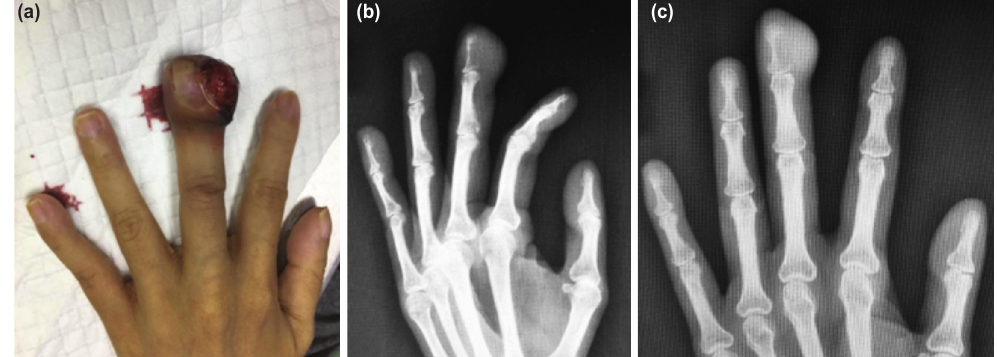
(a) Clinical picture of the left middle finger at three and a half months after onset of symptoms showing fungating mass at the Fig. 2: radio-dorsal aspect of the middle finger extending to the distal crease, (b and c) AP and oblique radiograph of the left middle finger showing an eccentric lytic lesion not extending to the distal interphalangeal joint with increase in soft tissue shadow at the distal